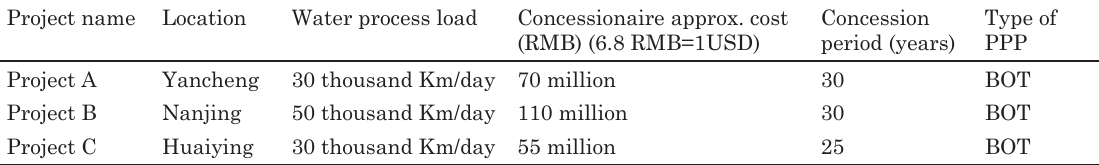
table 7. general information of the three selected PPP water projects